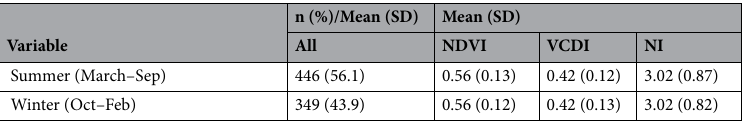
Table 1. Descriptive characteristics of the STEPS Study mothers who provided milk samples, and their infants in relation to residential green environment properties (n = 795) (750 m × 750 m grids). Sample sizes and percentages are given for categorical variables and means with standard deviations for continuous variables. Asterisks show significant associations between residential green environment variable and child/ maternal or study characteristic (p < 0.05). NDVI, Normalized Difference Vegetation Index, i.e. greenness; VCDI, Vegetation Cover Diversity; NI, Naturalness Index. 1 Chronic or gestational-related conditions during pregnancy. 2 Based on Index of Diet Quality (IDQ) 62